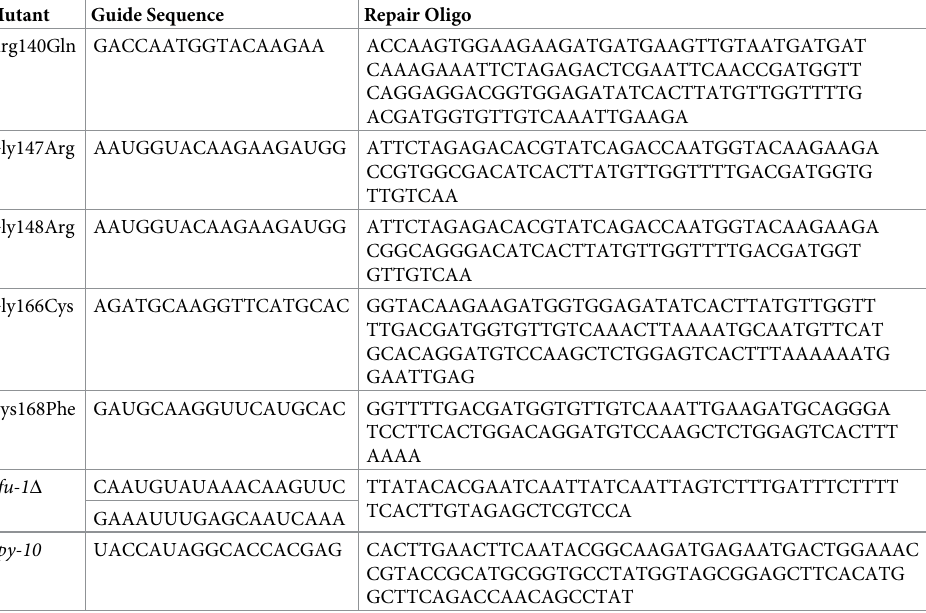
Table 5. CRISPR guide RNA and repair sequences. All sequences reported in 5’– 3’